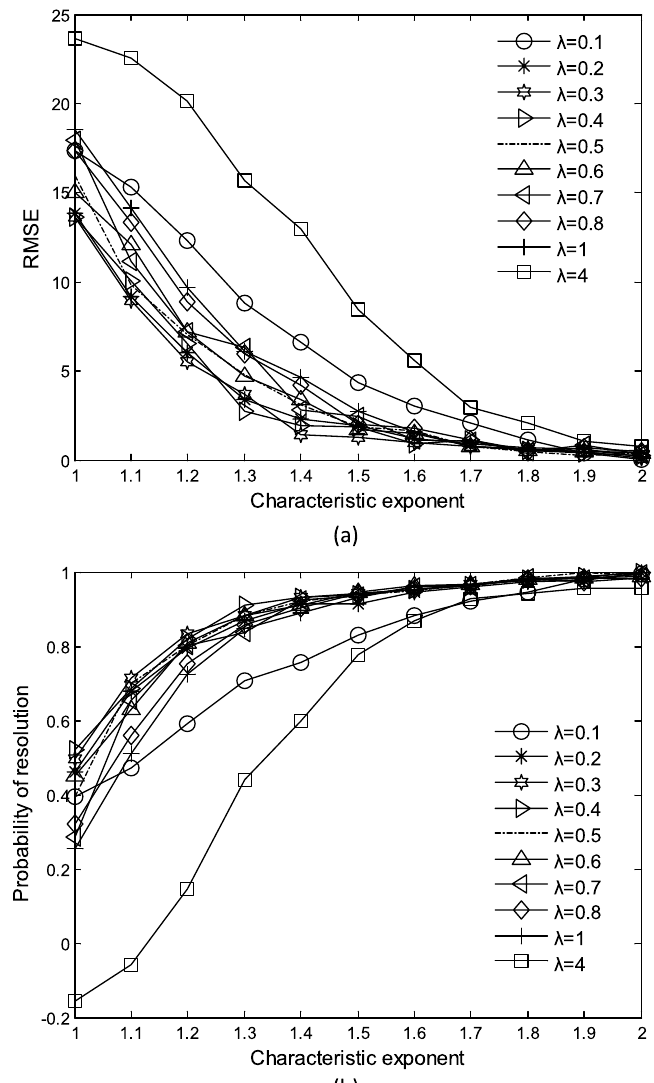
Fig. 3 Performances of the GLHSC-based TDE methods with different scaling parameters (cid:31) ( GSNR = 2dB ) a RMSE, b Probability of